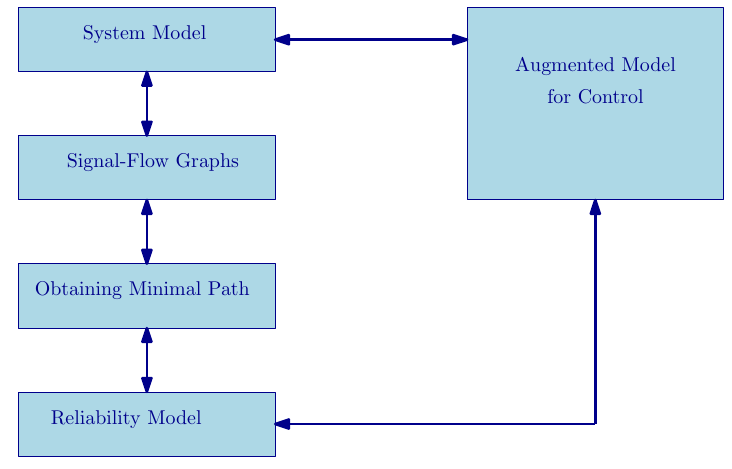
Figure 1. Structure diagram of the proposed